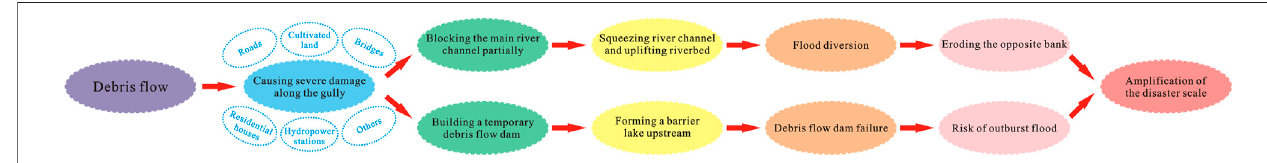
FIGURE 10 | Schematic diagram of the disaster chain effect of the “ 8 · 20 ” clustered debris fl ows event.